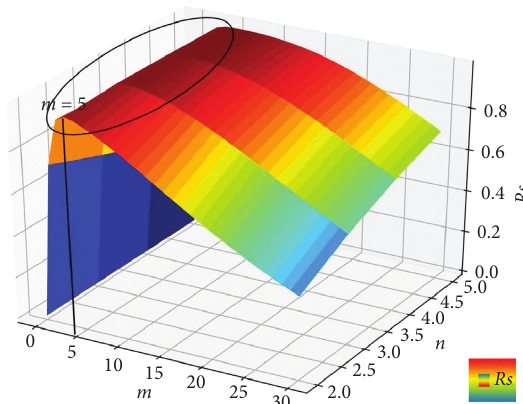
Figure 5: Curve of reliability of series and parallel systems changing with parameter m .